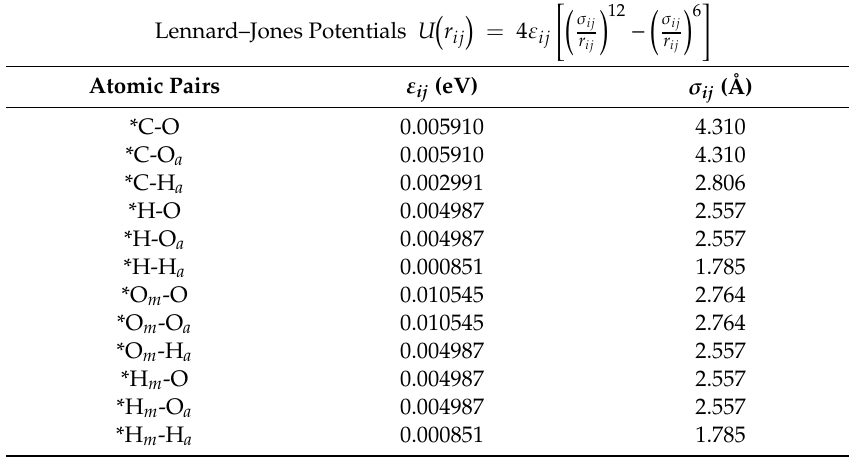
Table 5. Lennard–Jones potential describing the zeolite–methanol a